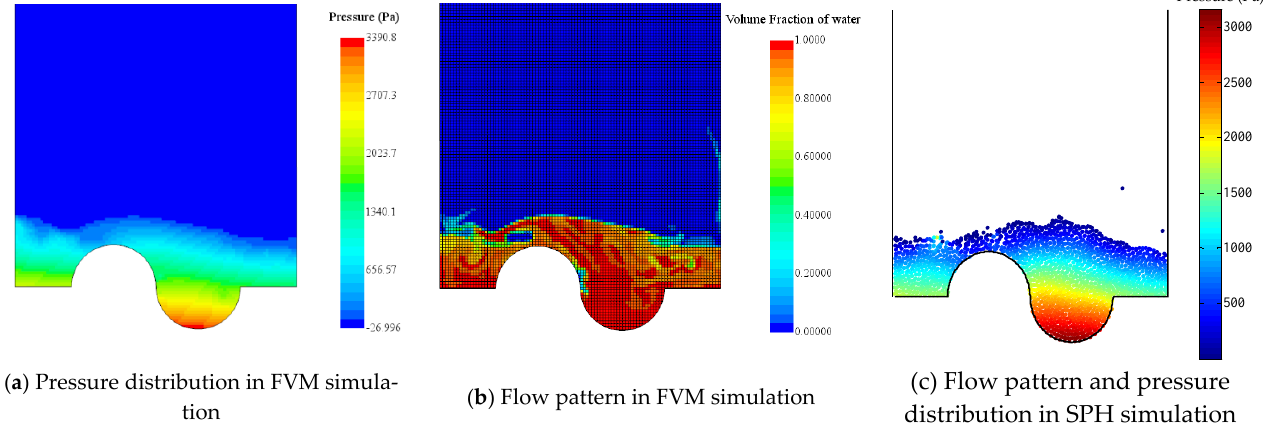
Figure 13. Comparisons of the flow pattern and pressure distribution at 29.4 s: ( a ) Pressure distribution in FVM simulation; ( b ) Flow pattern in FVM simulation; ( c ) Flow pattern and pressure distribution in SPH simulation.